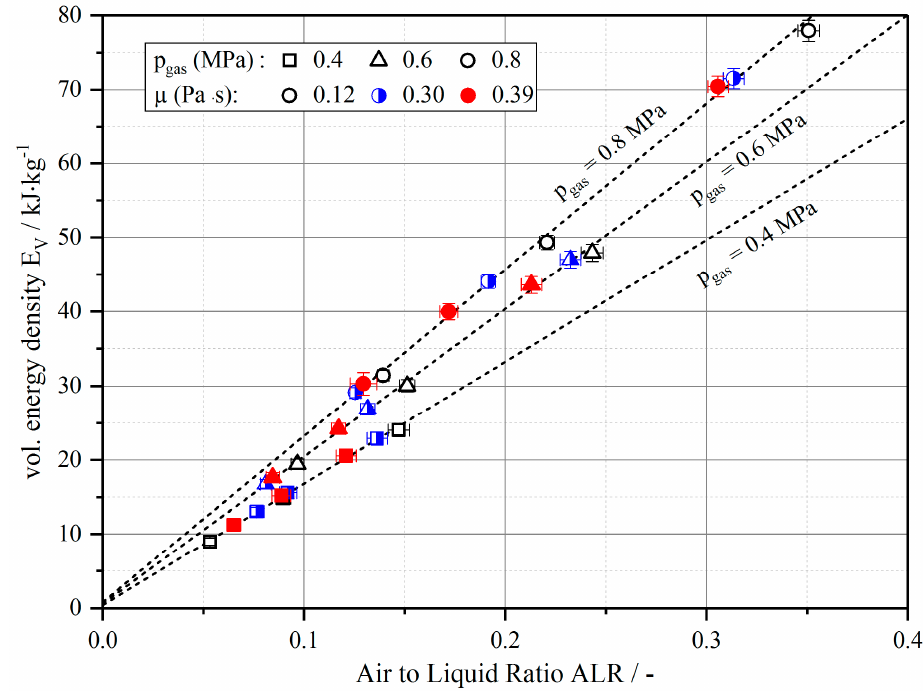
Figure 2. Linear prediction of the correlation between E V and air-to-liquid ratio (ALR) at constant p gas and ρ L av (dashed lines). Additionally, applied processing conditions are indicated: p gas = 0.4 MPa (squares), 0.6 MPa (triangles), and 0.8 MPa (circles); µ = 0.12 Pa · s (empty symbols), 0.30 Pa · s (half-filled symbols), and 0.39 Pa · s (filled symbols). Table 3. Gas pressures ( p gas ), liquid volume flow rates ( Q L ), resulting gas volume flow rates ( Q gas ), air/liquid mass ratios (ALR) and volumetric energy densities ( E V ) for atomizer 1 together with the uncertainty values u r ( γ ) of measured/calculated parameters Q ga s , ALR, and E V . Measurement values of Q gas are reported at normal conditions (273.15 K, 0.1013 MPa abs ) in normal cubic meters per hour (Nm 3 ∙ h − 1 ).